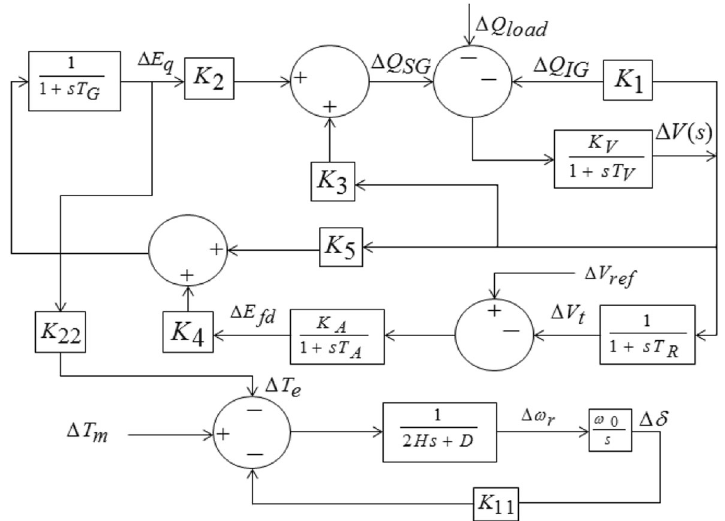
Fig. 1 Wind-diesel based studied power system model